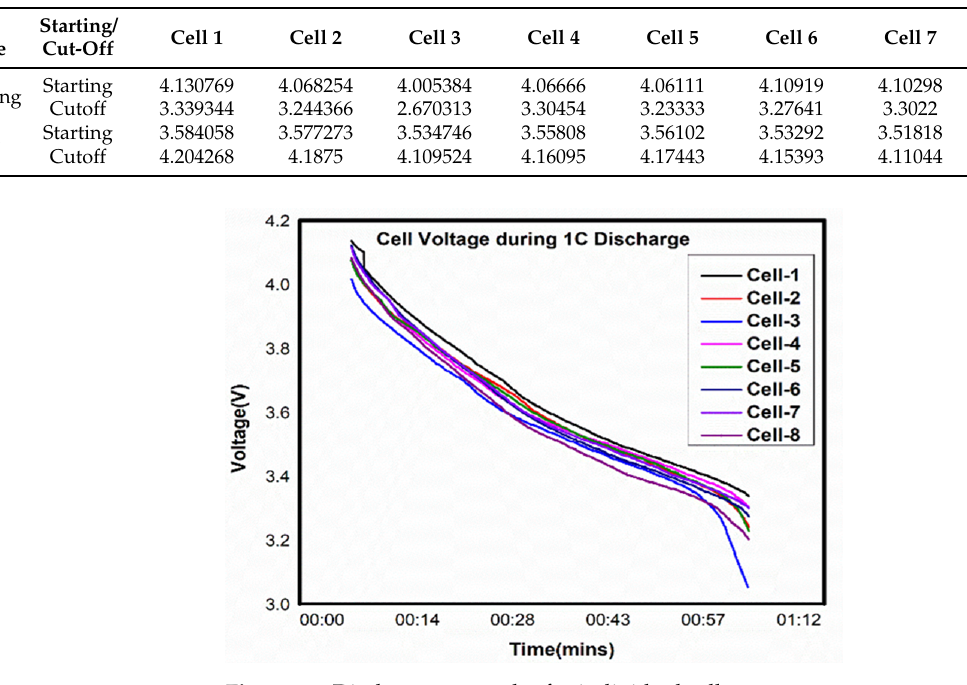
Figure 12. Discharge curve plot for individual